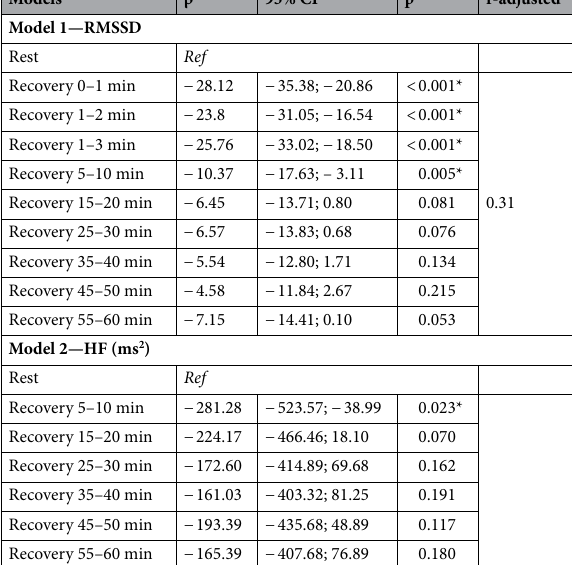
Table 3. Regression model between RMSSD and HF variables (ms 2 ) among moments. RMSSD root-mean square of differences between adjacent normal RR intervals, HF high